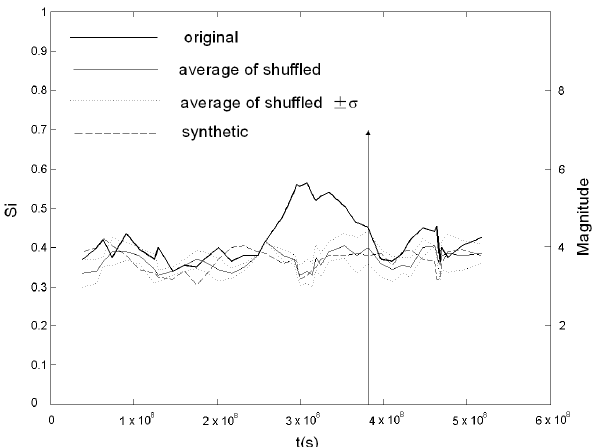
Fig. 5. The variation of Si versus time. In the figure, the Si value for the original series (thick solid line), the average (fine solid line) of the Si value obtained by 100 randomly shuffled versions within their ± 1 σ range (fine dotted lines) and the Si value obtained by synthetic data(fine dashed line) are plotted. The vertical arrow indicates M 7.0 Lijiang